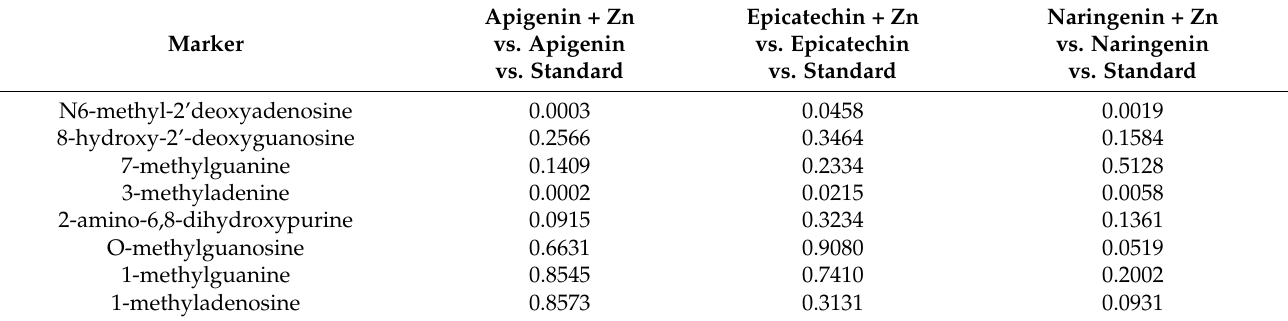
Figure 4. The content of selected methyl derivatives in urine of rats treated with 7,12-dime- thylbenz[a]anthracene in relation to supplementation. The differences were considered significant